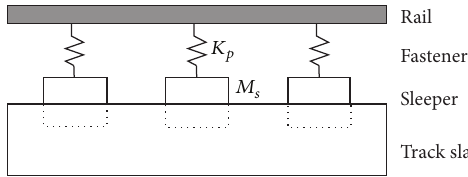
Figure 2: Combination of sleeper and slab of twin-block ballastless track